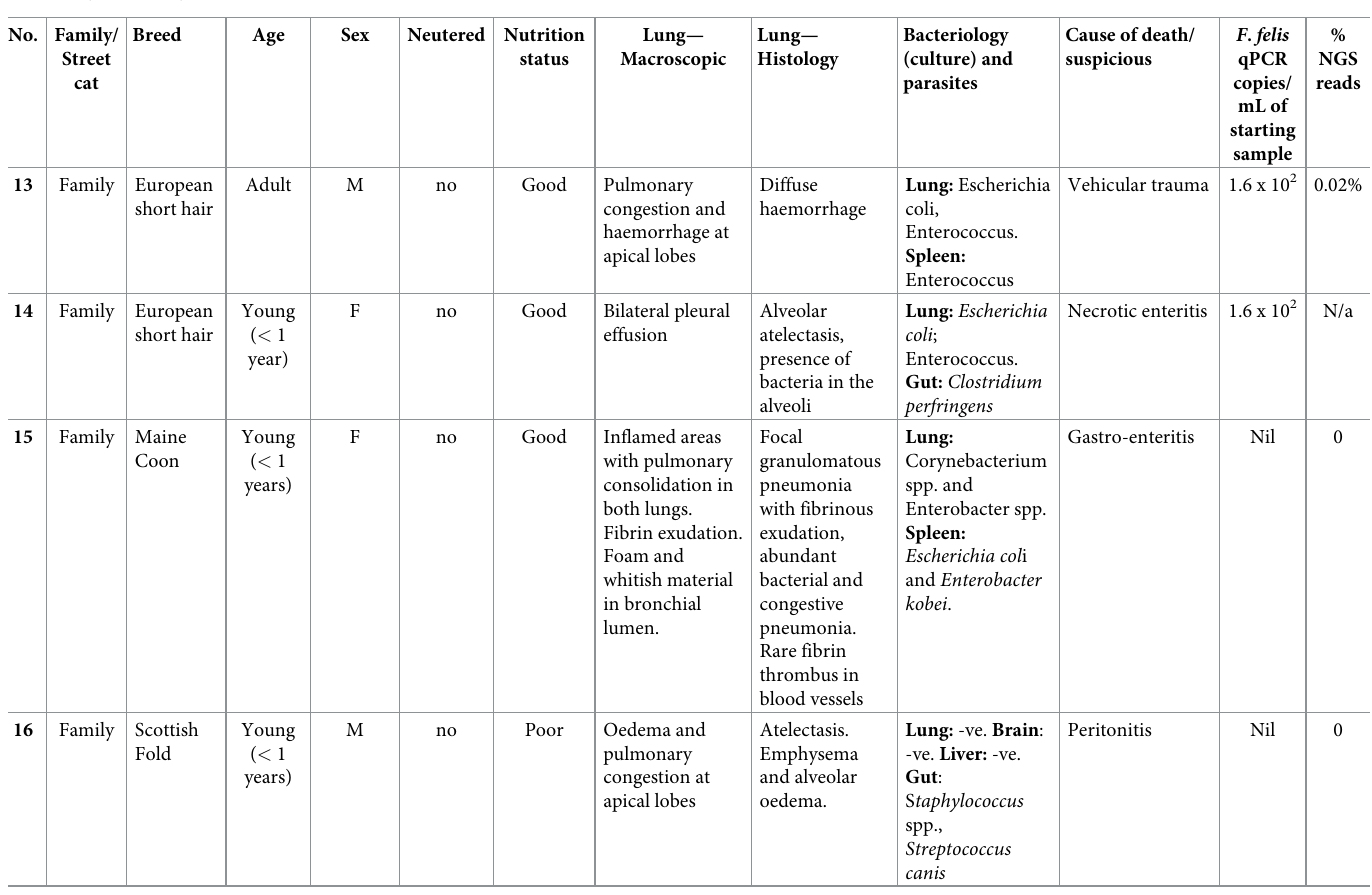
and 10 3 copies, carried out in triplicate. An inter-sample maximum variability of 0.3 cycle was considered acceptable. To test the specificity of a pathogen-specific qPCR assay, all positive sig- nals (15 cases) were re-sequenced using Sanger sequencing, employing one of the primers used for the quantitative qPCR. Only assays with 100% specificity were approved for further diagnostic use. The oligonucleotides designed and positively validated for the CARB-specific qPCR assay are: CARB-specific forward primer: CAGCACCTTATTAGCAGTATGTTTCC CARB-specific reverse primer: CCGCACAAGAGGTGGAACATGTGG CARB-specific probe: FAM— TCAGAGGCGATCTACTAACATTCTAGCCTAGGTA —BHQ1 These primers differ from those utilized in previous studies of CARB in other animal spe- cies, and PCR target regions of 16S rDNA are different [3, 32] The PCR conditions were as following: initial denaturation at 94˚C for 5 min, followed by 45 cycles with the profile: 94˚C 20 sec, 56˚C 30 sec, 72˚C 30 sec, with fluorescence acquisition at 56˚C. The PCR chemistry used was based on the thermostable FastStart ™ Taq DNA Poly- merase (Sigma, DE), with MgCl at a final concentration of 2.5 2